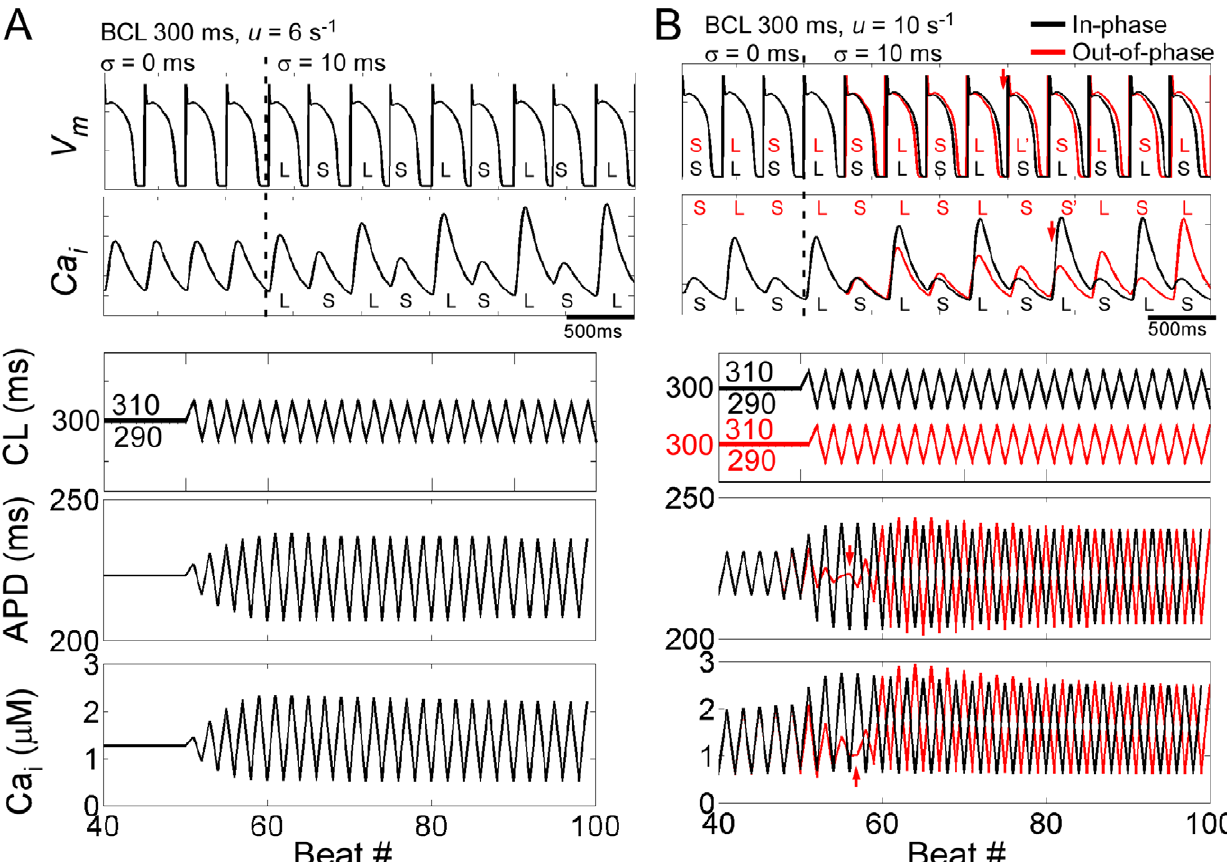
Figure 1. Cycle length oscillation in a single cell model. V m , Ca i , CL, APD, and Ca i transient amplitude before and during CLO for u =6 ( A ) and 10 ( B ) s 2 1 . L and S indicate long and short APDs and large and small Ca i transient amplitudes, respectively. In B , CLO applied in-phase (after 50 beats, black traces) and out-of-phase (after 51 beats, red traces) are shown. Phase reversal is indicated by a red arrow.